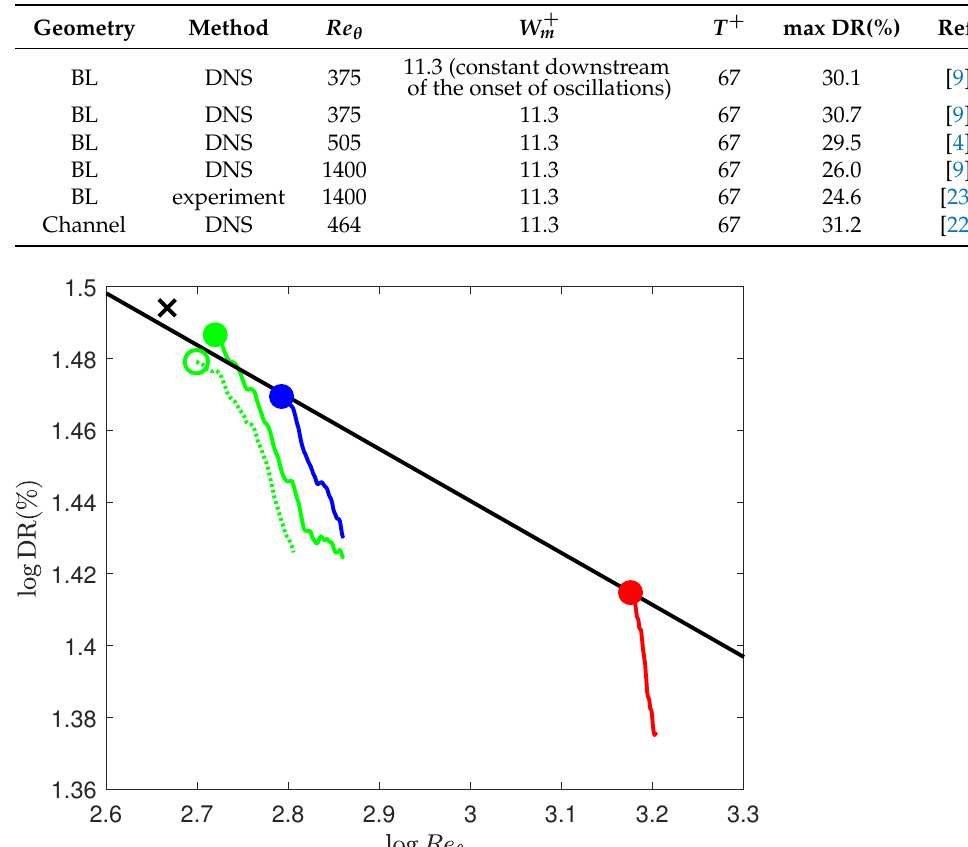
Table 2. Maximum DR in numerical and experimental investigations with W + m = 11.3 and T + = 67. BL—boundary layer. Re θ for channel flow is calculated according to Equation (13).